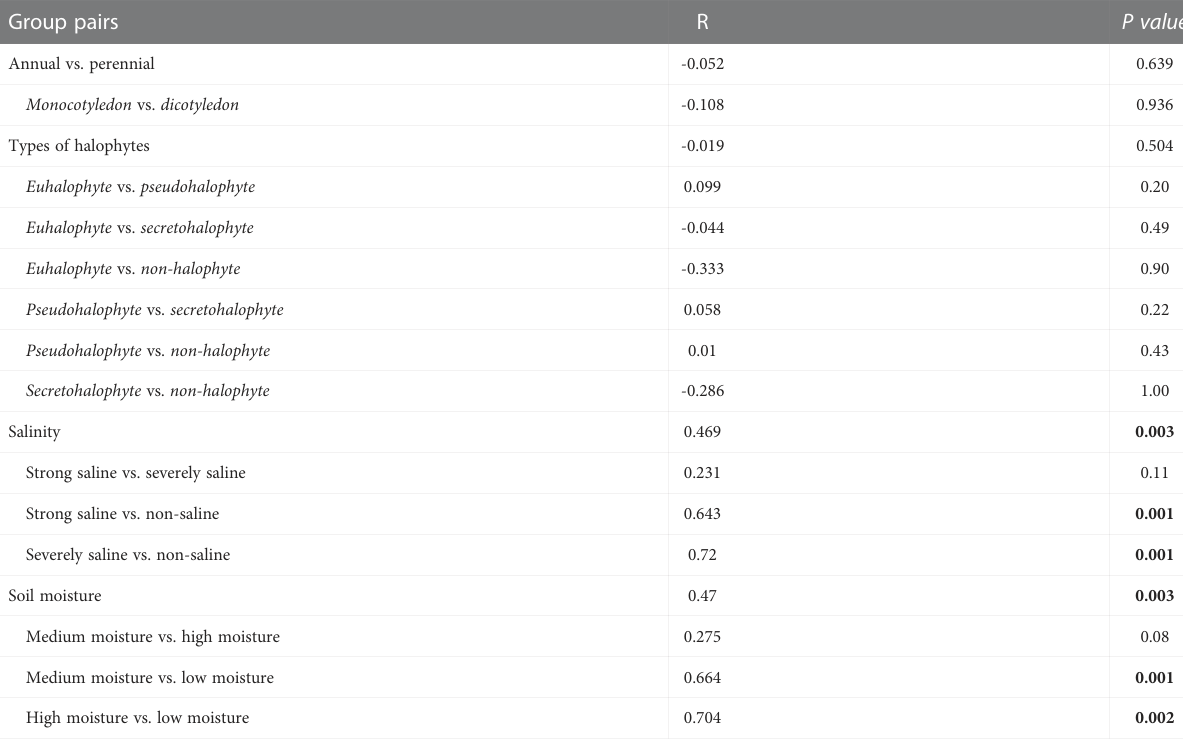
TABLE 4 Taxonomic analysis of the diazotrophic community